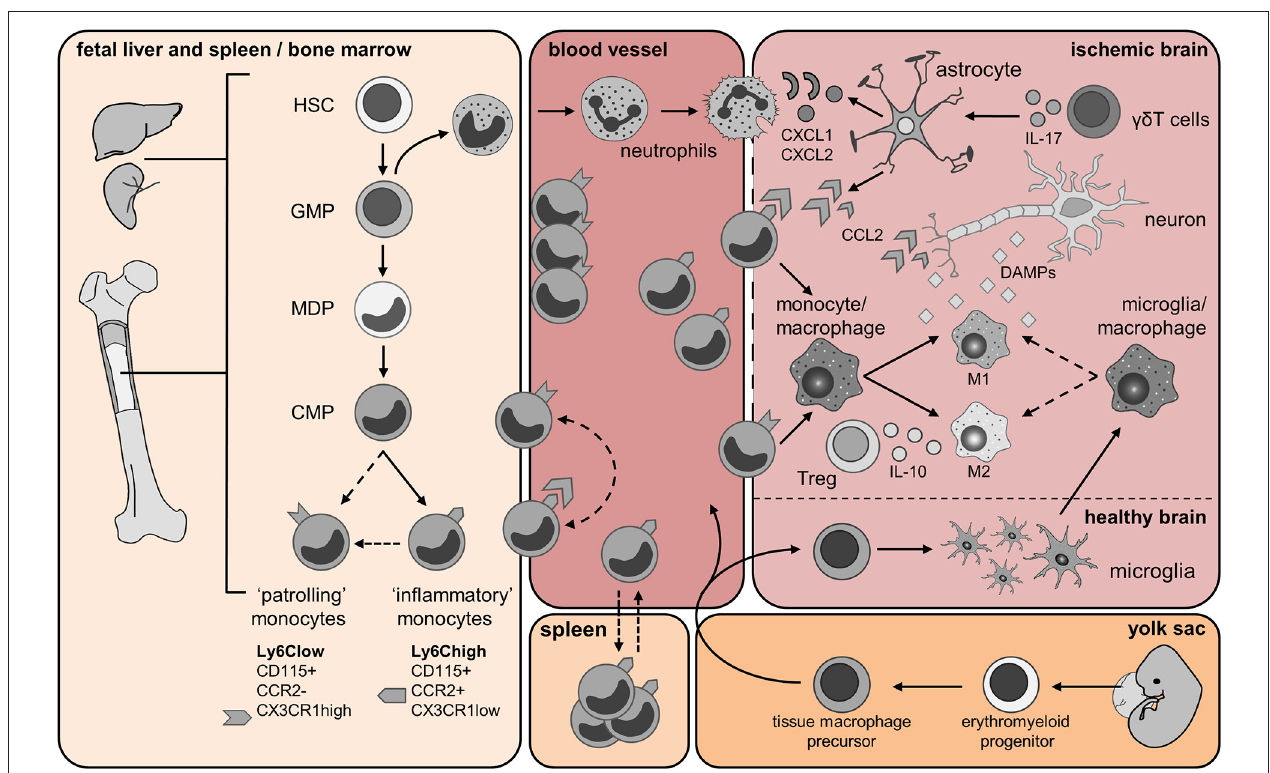
FIGURE 1 | Origin and trafficking of resident microglia and immune cells of myeloid origin . Fetal liver and spleen/bone marrow panel: Monocytes are generated from hematopoietic stem cells (HSCs) in the fetal liver and during adult life in the bone marrow (BM). The granulocyte macrophage precursors (GMP) give rise to immature neutrophils and the macrophage dendritic cell precursors (MDPs). Monocytes develop from hematopoietic stem cells (HSC) after myeloid lineage commitment through a series of increasingly restricted progenitors (GMP, granulocyte/monocyte progenitor; MDP, monocyte/dendritic cell progenitors). The common monocyte progenitor (CMP) is the direct precursors of mature Ly6C high and Ly6C low